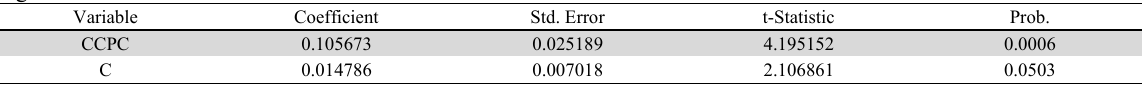
Regression of CPIBP and CCPC Variable